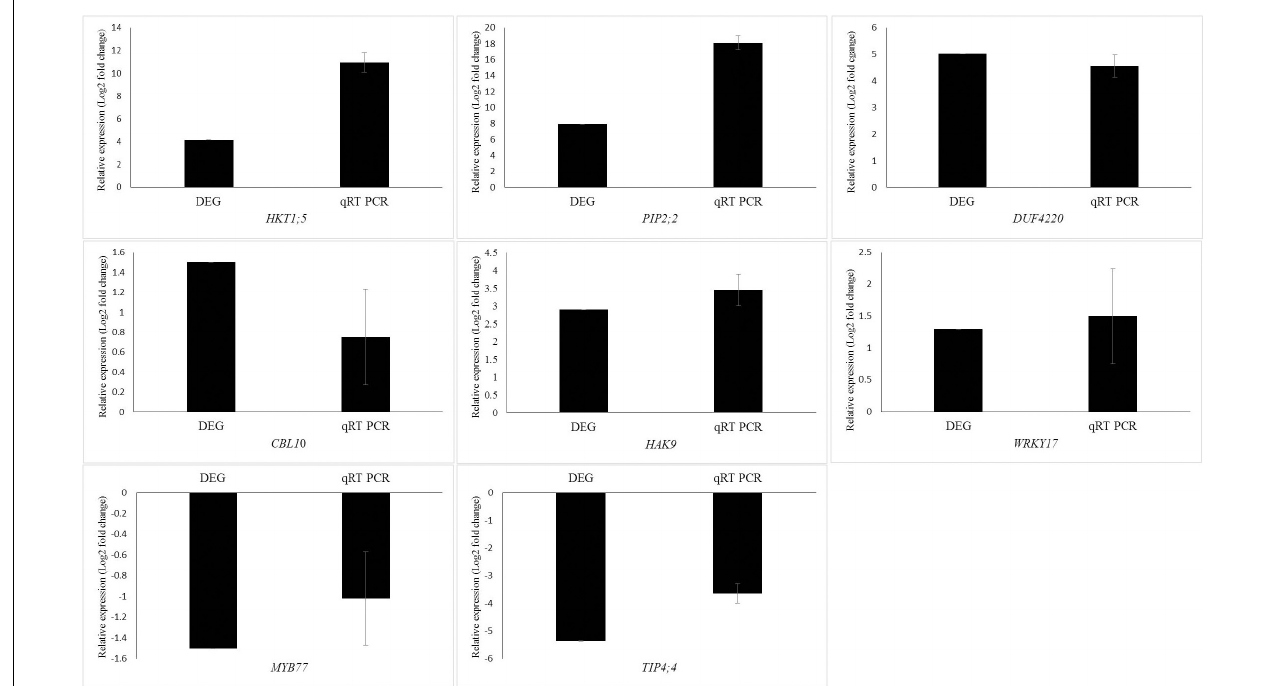
FIGURE 4 | Validation of transcriptional changes of eight randomly selected genes from the DEGs using qRT-PCR of Puccinellia nuttalliana under NaCl stress. Values are means + SE of four biological replicates. Each biological replicate is comprised of three technical replicates.